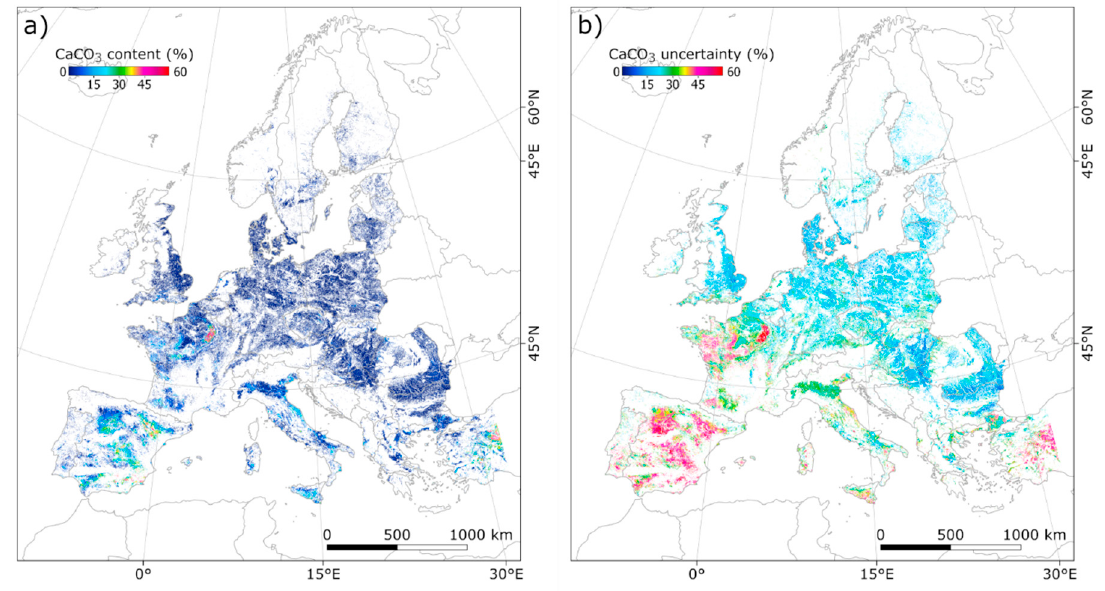
Figure 4. ( a ) Soil European CaCO 3 map using the full synthetic soil image (SYSI) as model predictor; ( b ) the CaCO 3 uncertainty map.